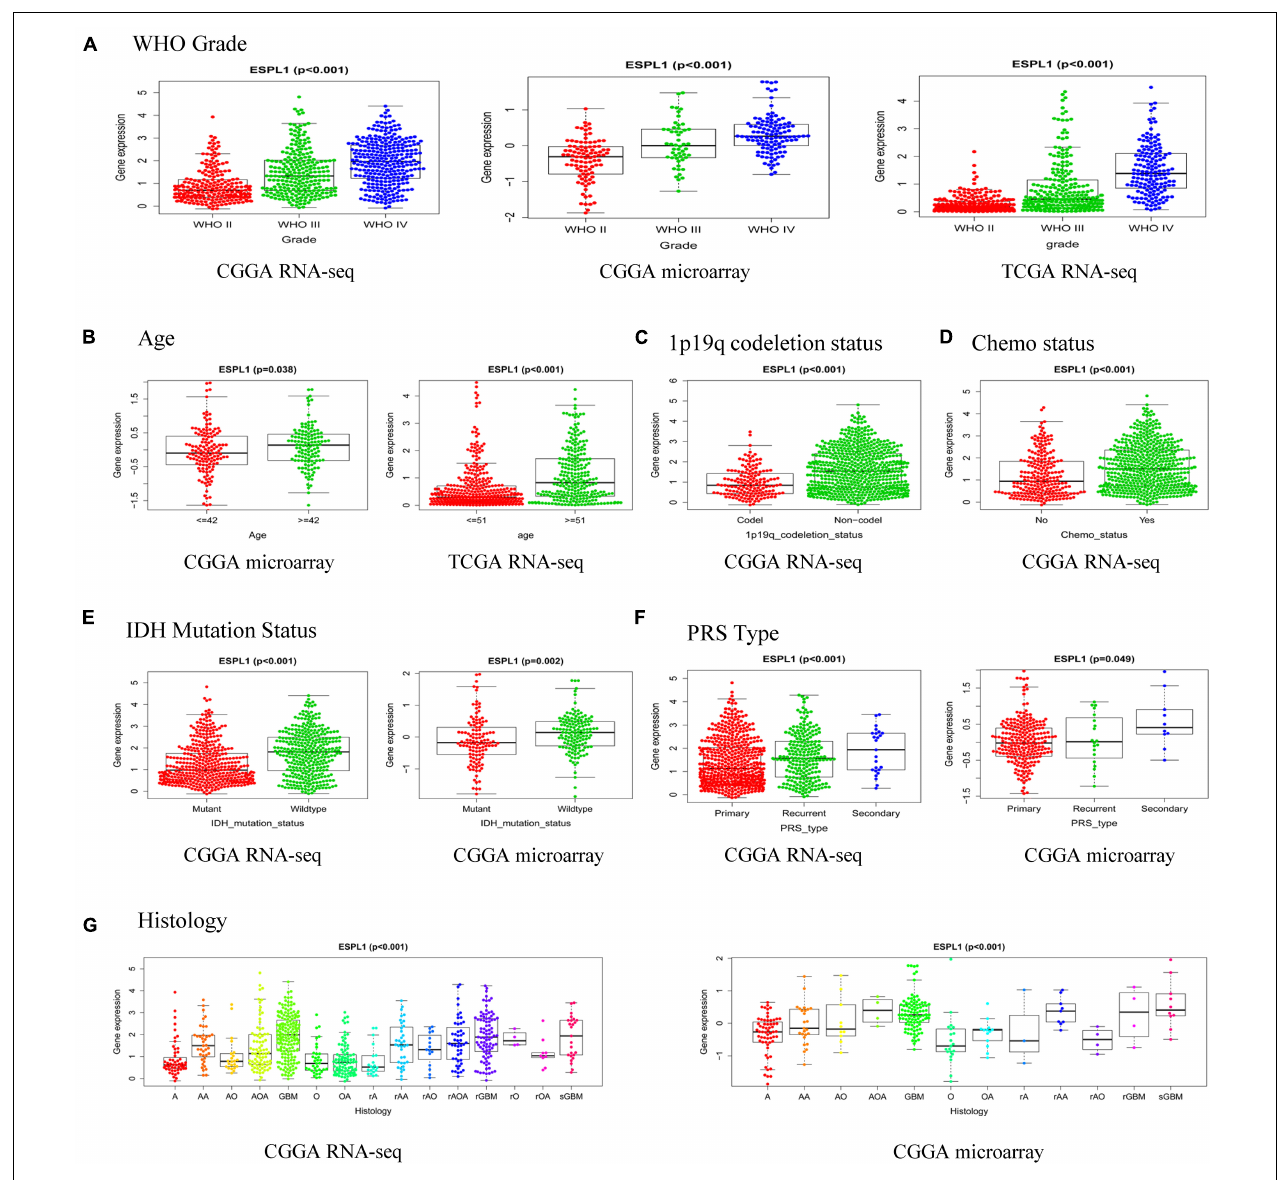
FIGURE 5 | Relationship between the expression of ESPL1 in glioma and clinicopathological characteristics in the CGGA RNA-seq, CGGA microarray, and TCGA RNA-seq datasets. (A) Grade. (B) Age. (C) 1p19q_codeletion status. (D) Chemotherapy status. (E) IDH mutation status. (F) PRS type. (G) Histology (A, astrocytoma; AA, anaplastic astrocytoma; AO, anaplastic oligodendroglioma; AOA, anaplastic oligoastrocytoma; GBM, glioblastoma; O, oligodendroglioma; OA, oligoastrocytoma; rA, relapse astrocytoma; rAA, relapse anaplastic astrocytoma; rAO, relapse anaplastic oligodendroglioma; rAOA, relapse anaplastic oligoastrocytoma; rGBM, relapse oligodendroglioma; rO, relapse oligodendroglioma; rOA, relapse oligoastrocytoma; sGBM, secondary relapse oligodendroglioma).